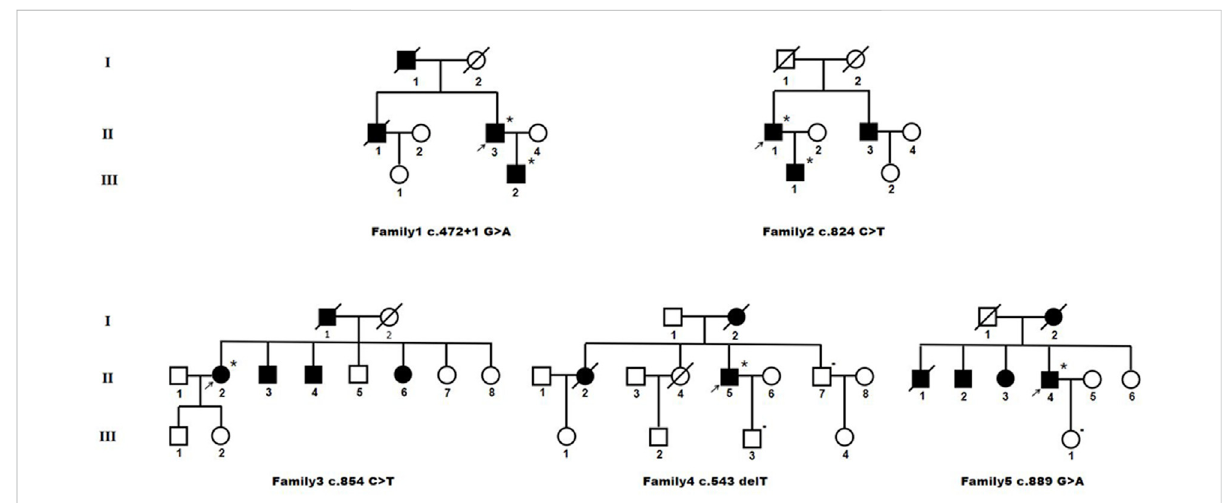
FIGURE 3 Pedigreechartsofheterozygous HTRA1 pathogenicvariantfamilies.Squaresindicatemales;circlesindicatefemales;theblacksymbolsindicate affected individuals; *indicates patient with single HTRA1 pathogenic variant; - indicates patient without HTRA1 pathogenic variant; arrows indicate the